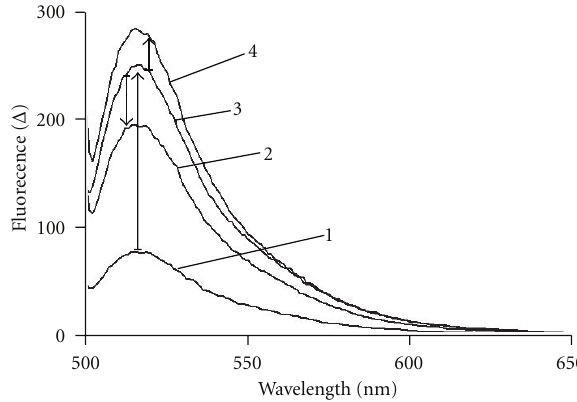
Figure 2: Fluorescence emission spectra of (1) FITC-labeled E. coli O111:B4 LPS (5 μ M). (2) Decrease in fluorescence observed upon addition of chlorpromazine (20 μ M) to the FITC-LPS:AGP complex. (3) FITC-LPS (5 μ M) in complex with human AGP (25 μ M). (4) FITC-LPS (5 μ M) in complex with human AGP (25 μ M) in the presence of EDTA